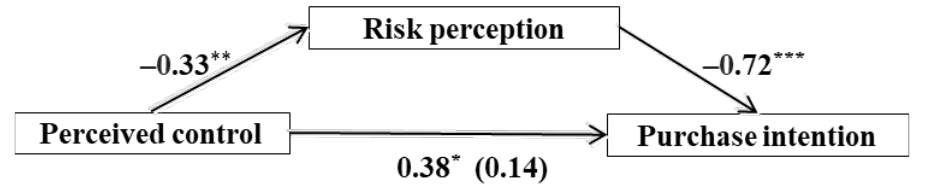
Figure 4. Mediation model. N = 115; * p < 0.05; ** p < 0.01; *** p < 0.001.